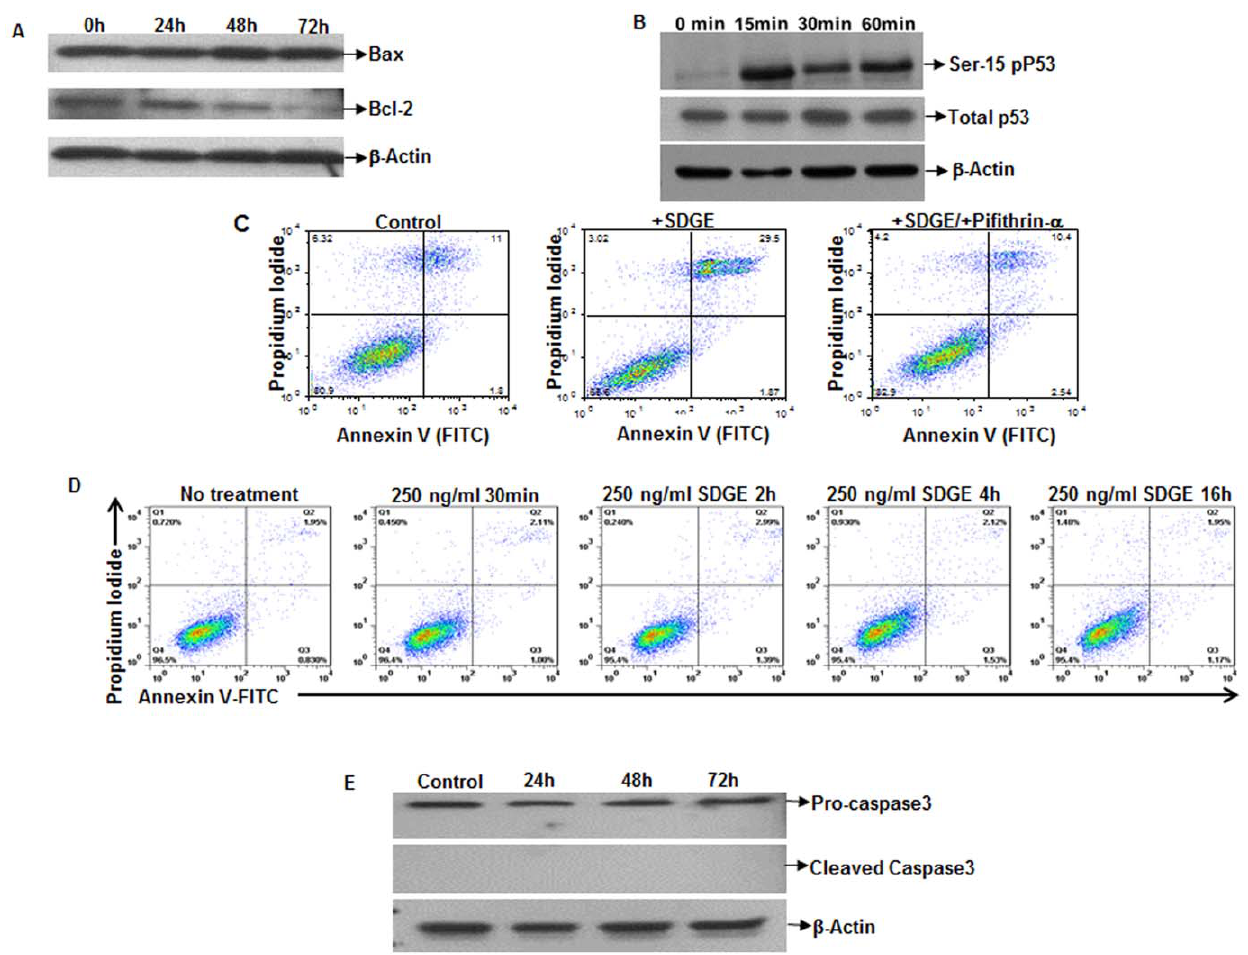
Figure 6. SDGE mediates endometrial cancer cell apoptosis through the activation of p53. After treating Ishikawa cells with SDGE (250 ng/ml) for the designated time points, the cells were harvested and lysates were analyzed by Western blotting for expression of Bcl-2 and Bax (A). Phosphorylation of Ser-15 of p53 was monitored in Ishikawa cells treated with SDGE (250 ng/ml) (B). Ishikawa cells were incubated with SDGE in the presence or absence of pifithrin- a for 18 h. Control Ishikawa cells were not exposed to either SDGE or pifithrin- a . (C) Cells were harvested and apoptosis was measured by flow cytometry after staining with FITC-Annexin V and propidium iodide. Apoptosis in the p53 neg SKOV-3 cells after treatment with SDGE (250 ng/ml) was also measured by the FITC-Annexin V assay (D) or by monitoring the levels of cleaved Caspase3 by Western blotting (E) at the designated time intervals.